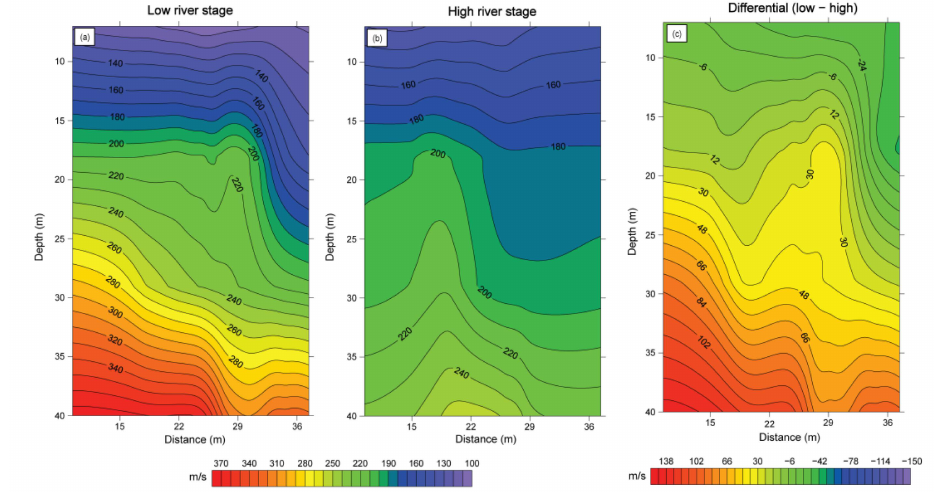
Figure 6. West side (25 m from levee toe) shear-wave seismic profiles. Kriging-interpolated CMP- based interval velocities during ( a ) low and ( b ) high river stages, and the ( c ) differential shear-wave velocity. Mean = 35.5 m/s and standard deviation = ± 54